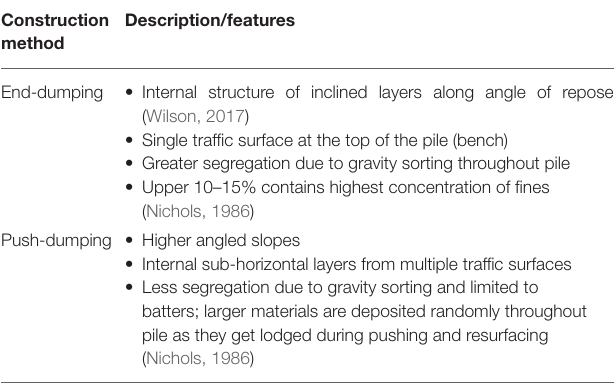
TABLE 1 | Structural features for end- and push-dumping construction